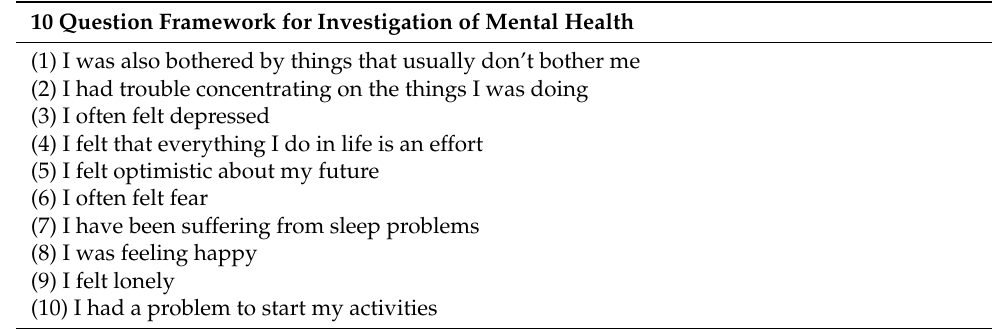
Table A2. 10-question framework for investigation of mental health in context of depression.